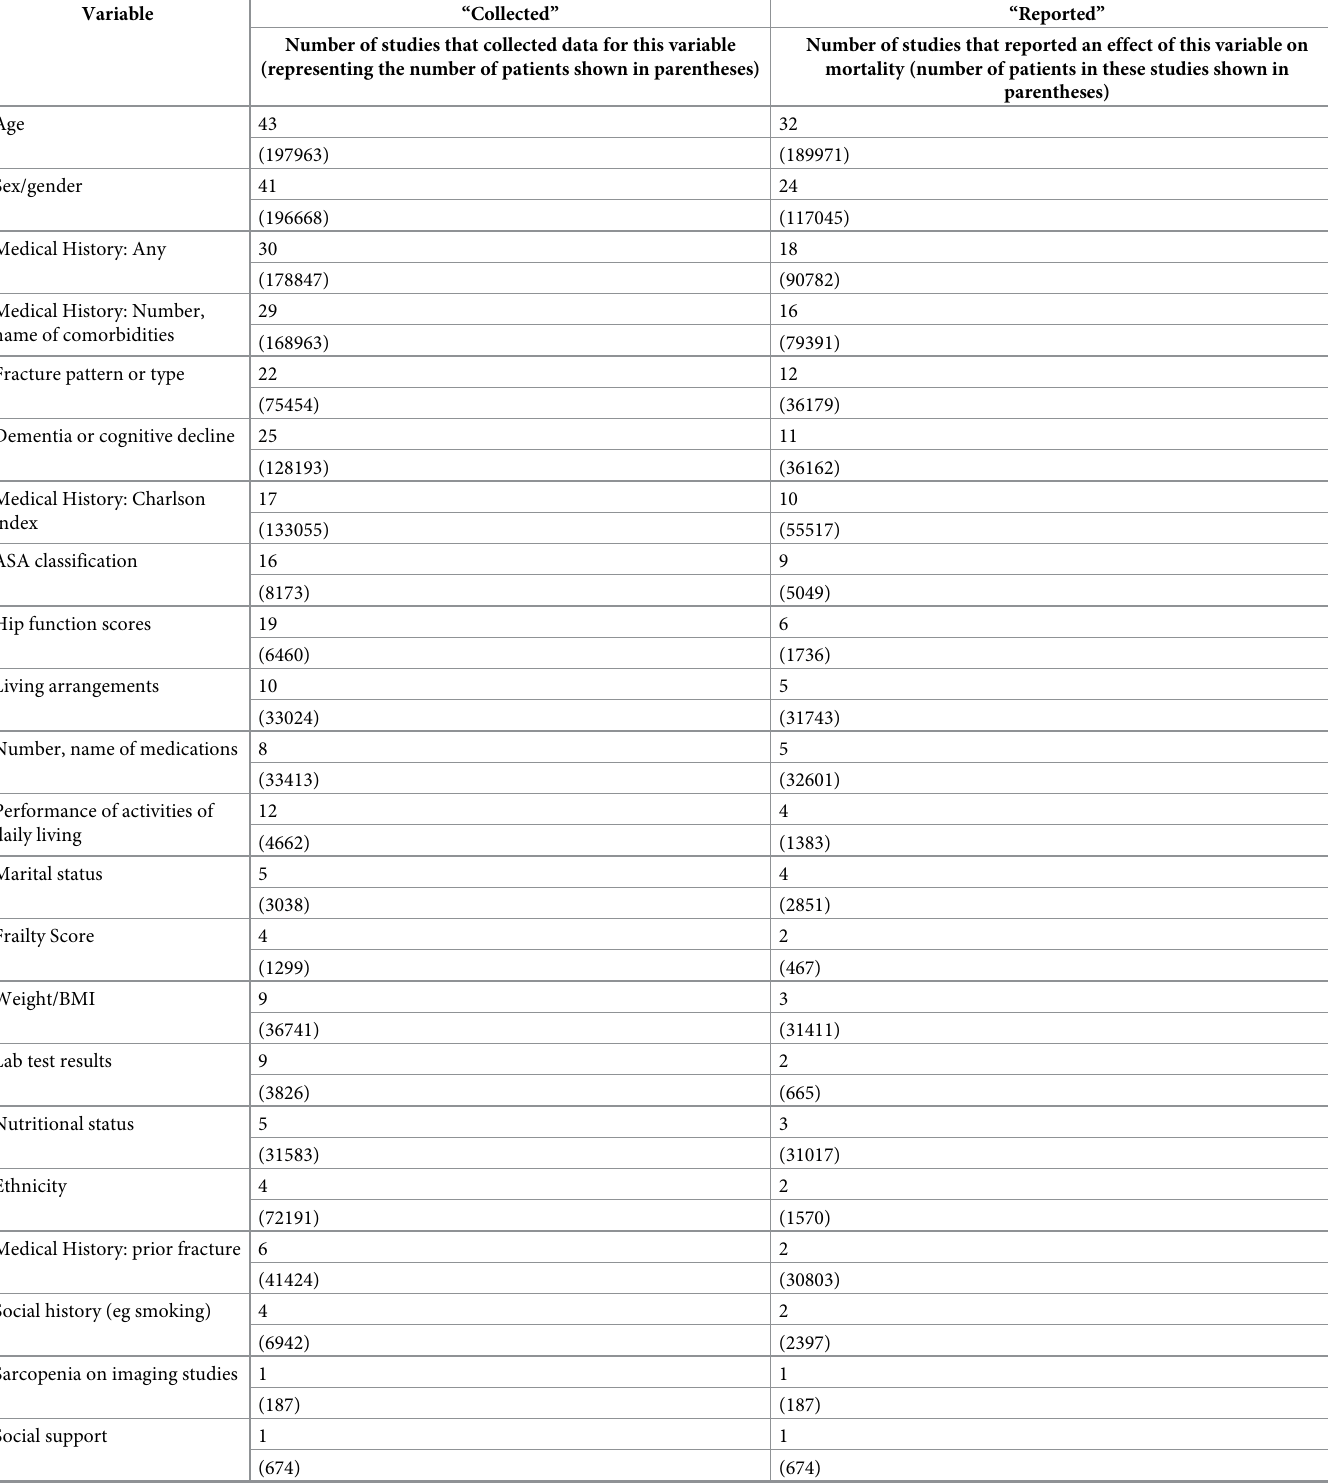
Table 3. Master variable